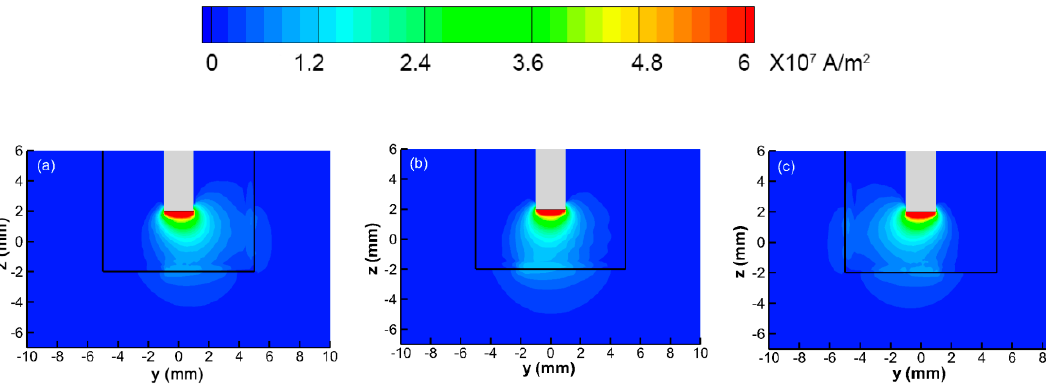
Figure 5. Distribution of MOA temperature at section x = 0 at different times: ( a ) time; ( b ) t = 0.025 s; ( c ) t = 0.0252 s; ( d ) t = 0.027 s; ( e ) t = 0.35 s; ( f ) t = 0.62 s.